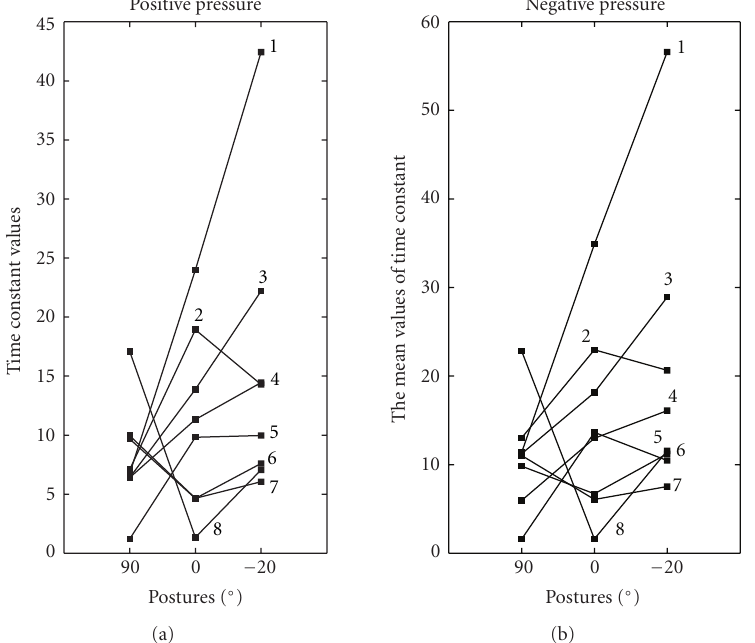
Figure 6: The mean values of time constant variation R A C in the positive pressure edges (a) and negative pressure edges (b), in 8 ears, according to three di ff erent postures : up-right (90 ◦ ), supine flat on their back on a horizontal plane (0 ◦ ), and head down ( − 20 ◦ ) with respect to horizontal plane. Noticed that (a) and (b) are, respectively, Figures 6(a) and